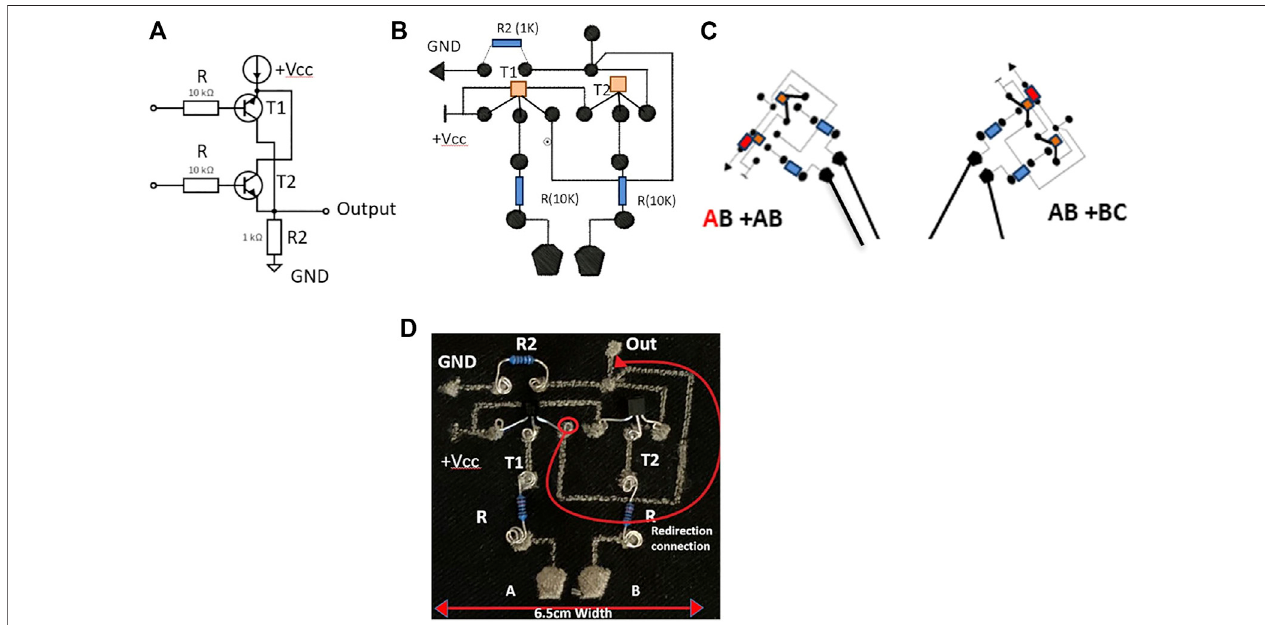
FIGURE 3 | OR logic gate: (A) 2-input logic OR gate can be constructed using RTL resistor – transistor, (B) embroidered digitized design for the OR logic gate, (C) cluster of two OR gates in the PLA garment design, and (D) embroidered OR logic gate and design modi fi cations completed in order to limit shorts from occurring.